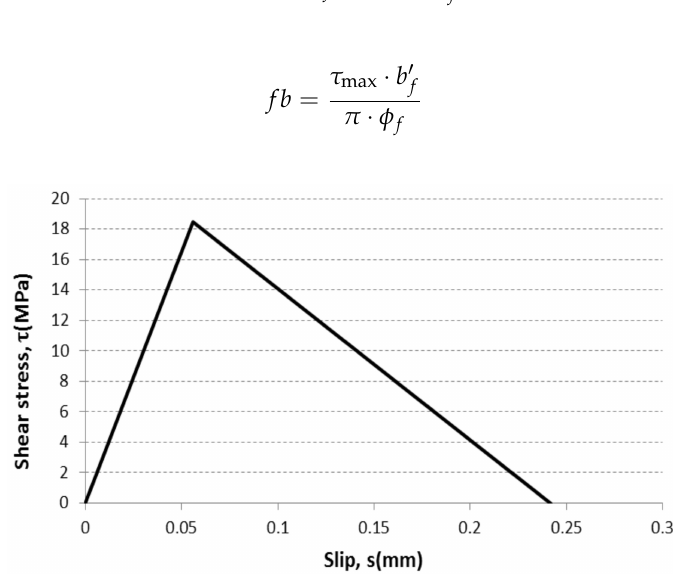
Figure 5. Bond slip law for FRP laminate agreeing with